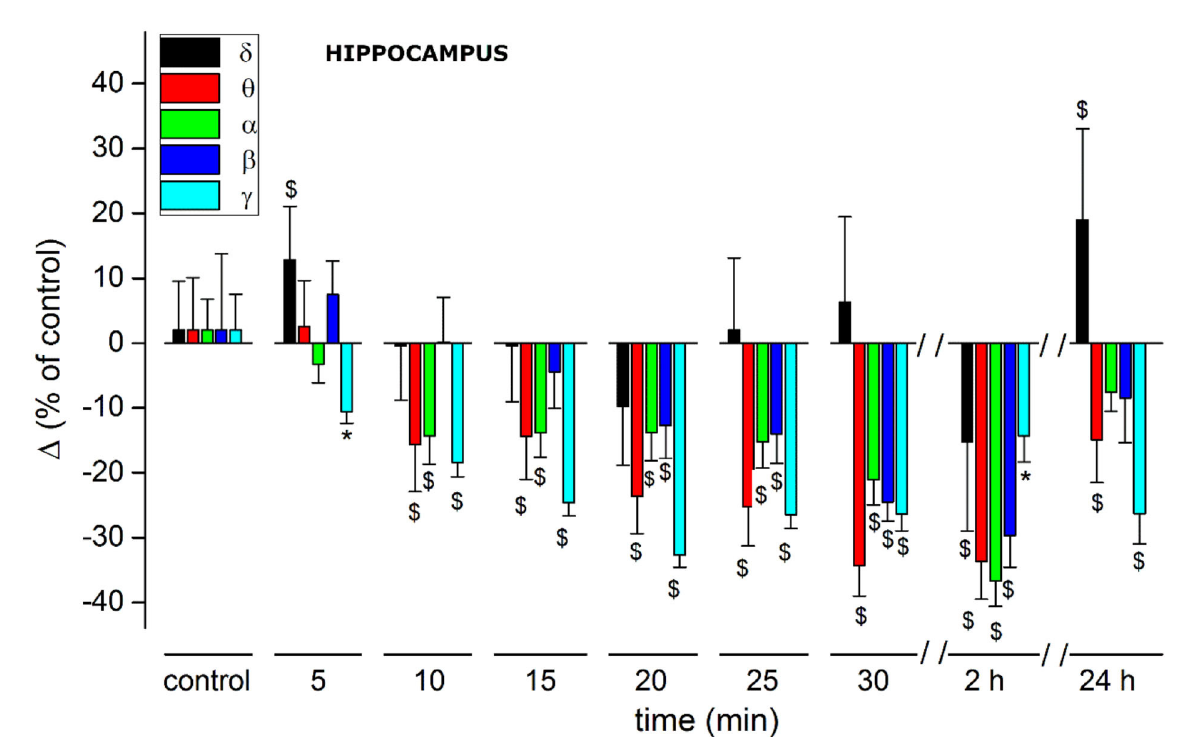
FIGURE10 Histogram summarizing average relative % changes of δ , θ , α , β , γ , EEG bands amplitude (measured as FFT area relative to a 5-min window) and recorded in hippocampus. Histograms at control are exclusively functional to mate EEG color bands with corresponding error bars. Values correspond to % ± s.e. Original data are reported in Table 3. Two-way ANOVA with Dunnet test was used to compare the control EEG amplitude of groups before treatment with values after treatment. * p < 0.05; $ p < 0.01.